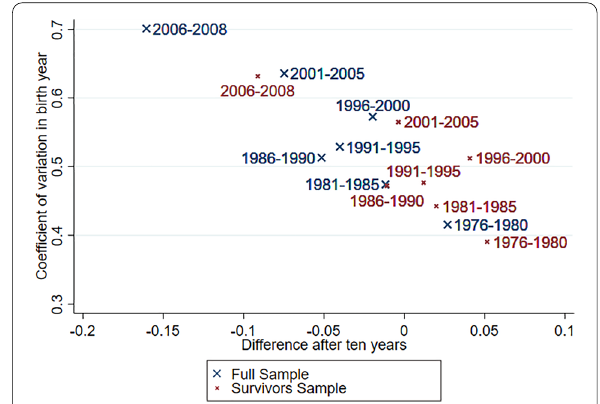
Fig. 7 The link between the wage dispersion in the birth year and the difference in the wage dispersion after 10 years, for chosen birth year